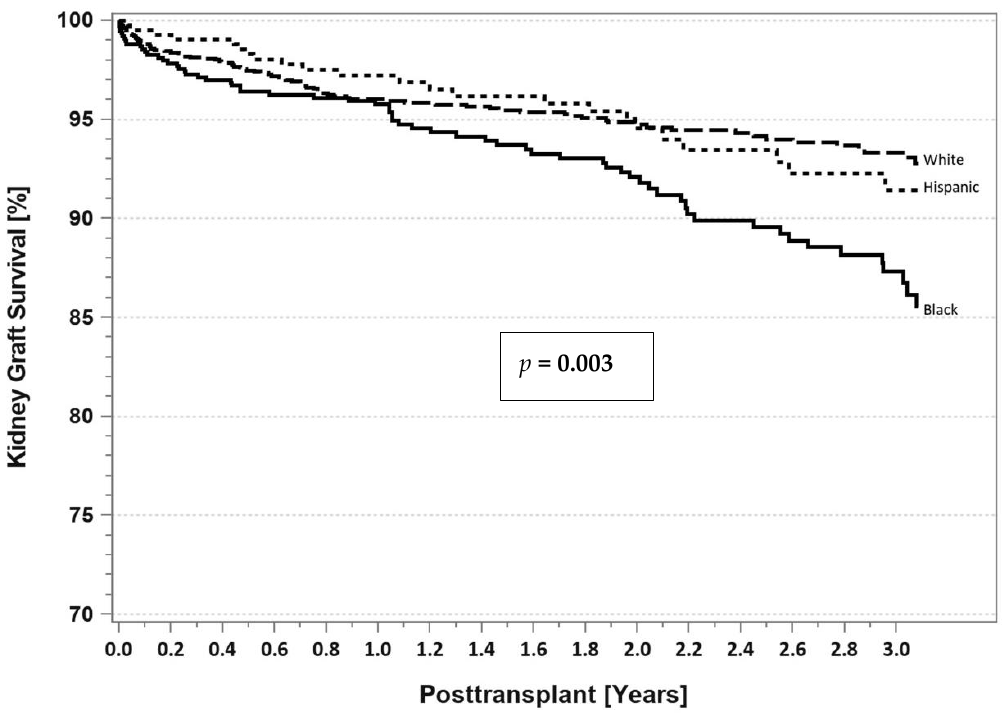
Figure 11. SPKT kidney graft survival according to recipient race in patients identified as having